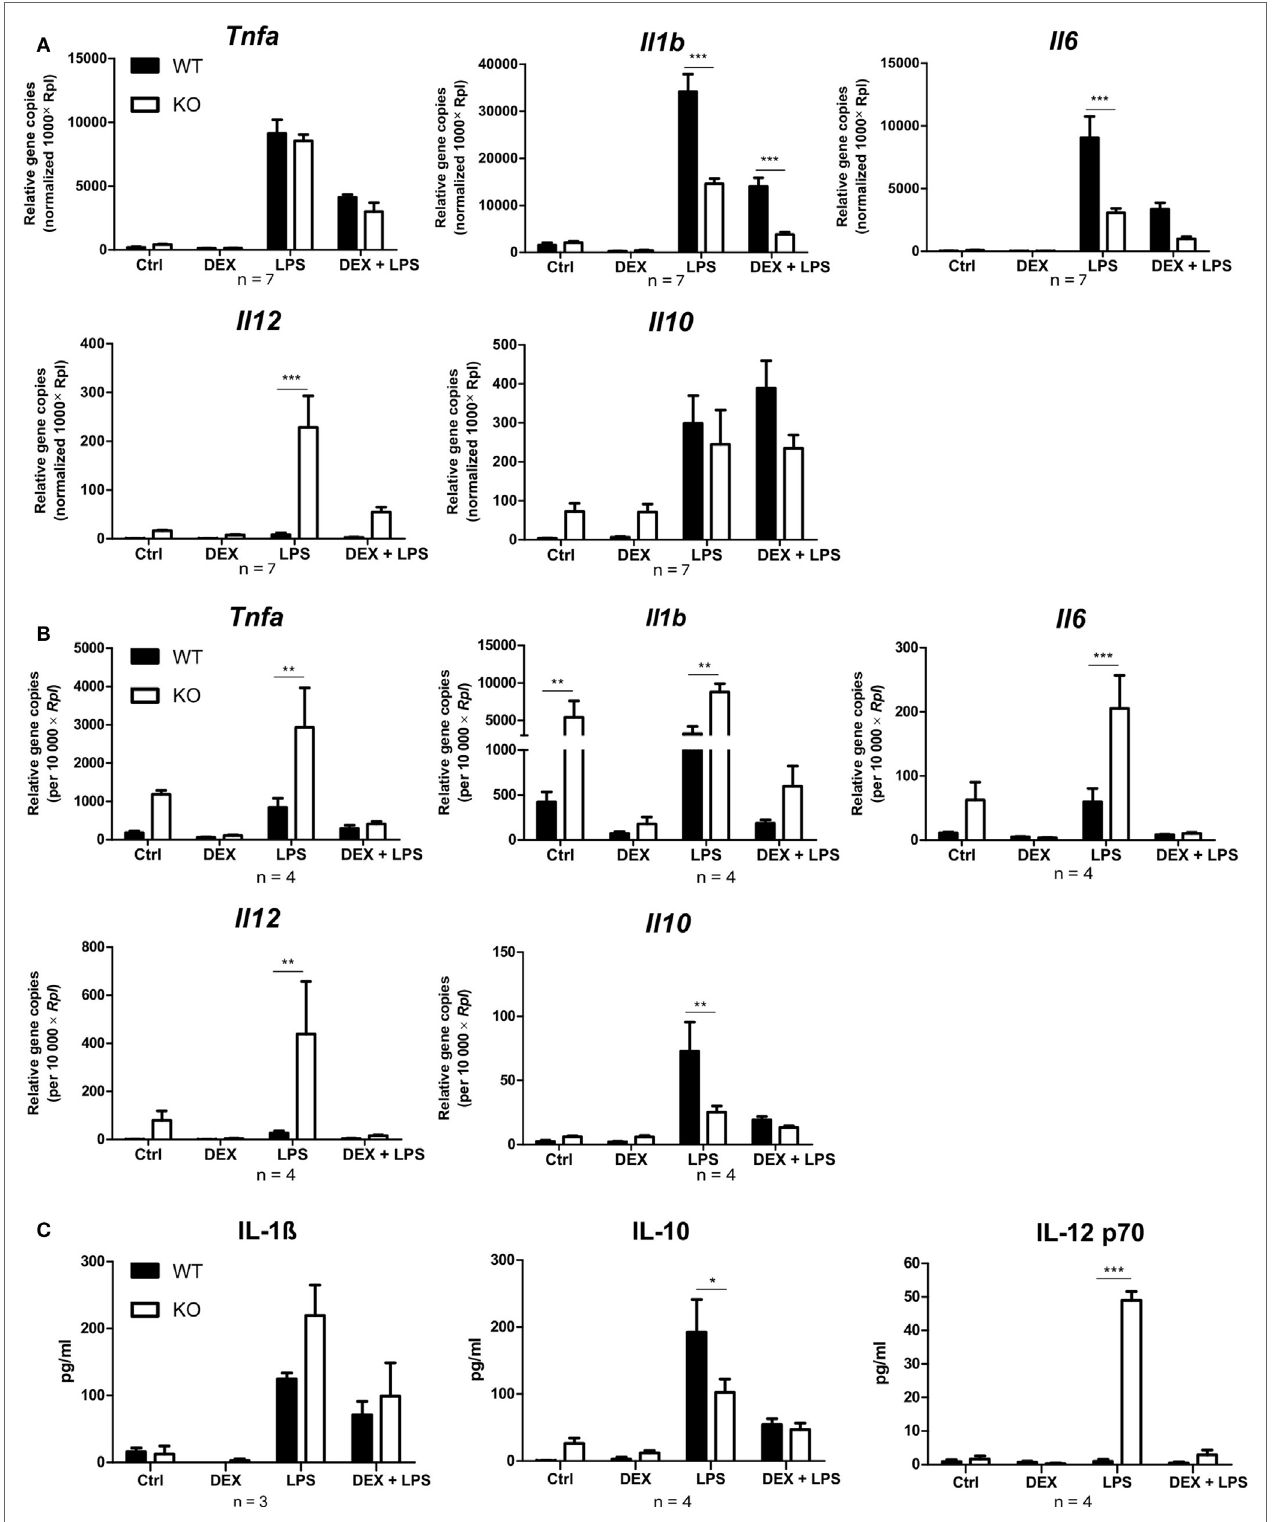
FigUre 3 | Peroxisome proliferator-activated receptor- γ KO cells display a pro-inflammatory phenotype. (a–c) ER-Hoxb8 cells d5 were treated with dexamethasone (DEX) (100 nM) and/or LPS (1 µg/ml) for 3 (a) , 24 (B) , or 48 h (c) . (a,B) The cells were analyzed for gene expression of the indicated genes using qPCR. (c) Supernatants were examined for IL-1 β concentration using ELISA and for IL-10 and IL12 p70 concentration using CBA. (a–c) The bars represent the mean with the SEM of three to seven independent experiments (* p < 0.05, ** p < 0.01, *** p < 0.001) (calculated by using two-way